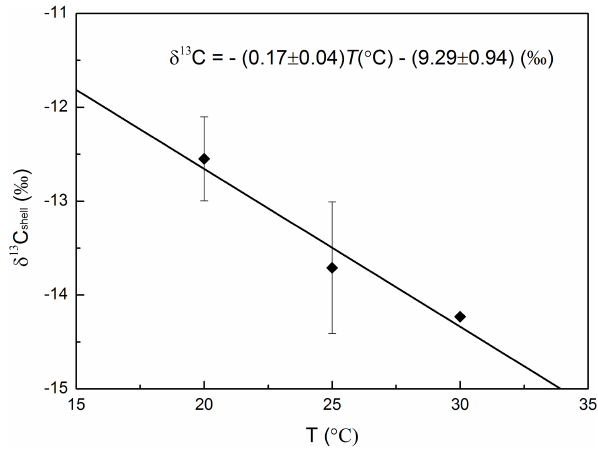
Figure 9. Relationship between δ 13 C of snail shell aragonite (fed without carbonate) and different culture